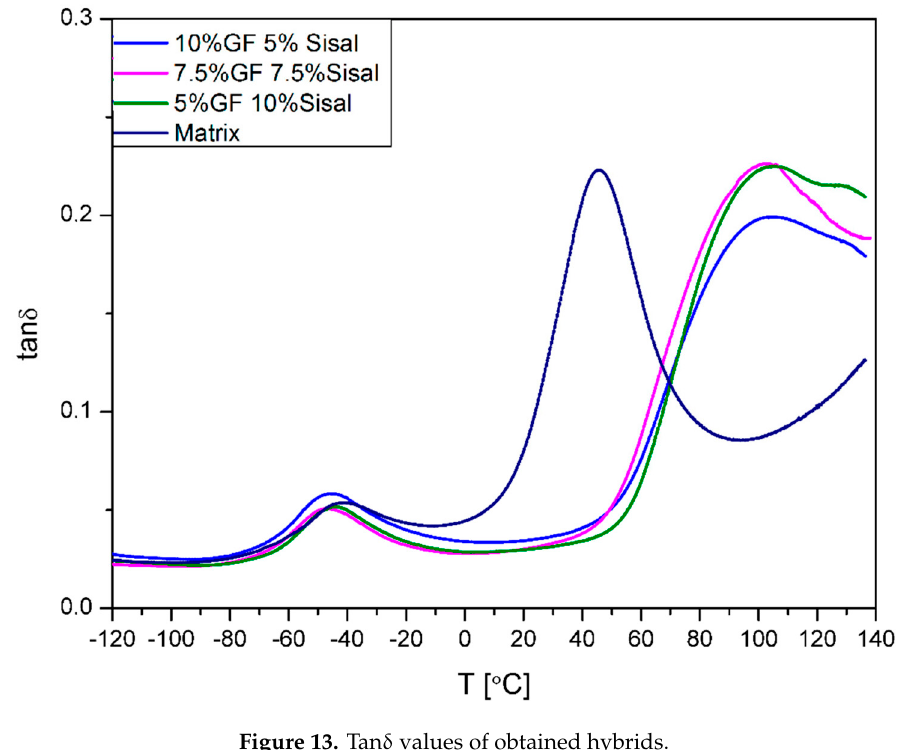
Figure 12. Loss factor (Tan δ ) values of obtained composites.